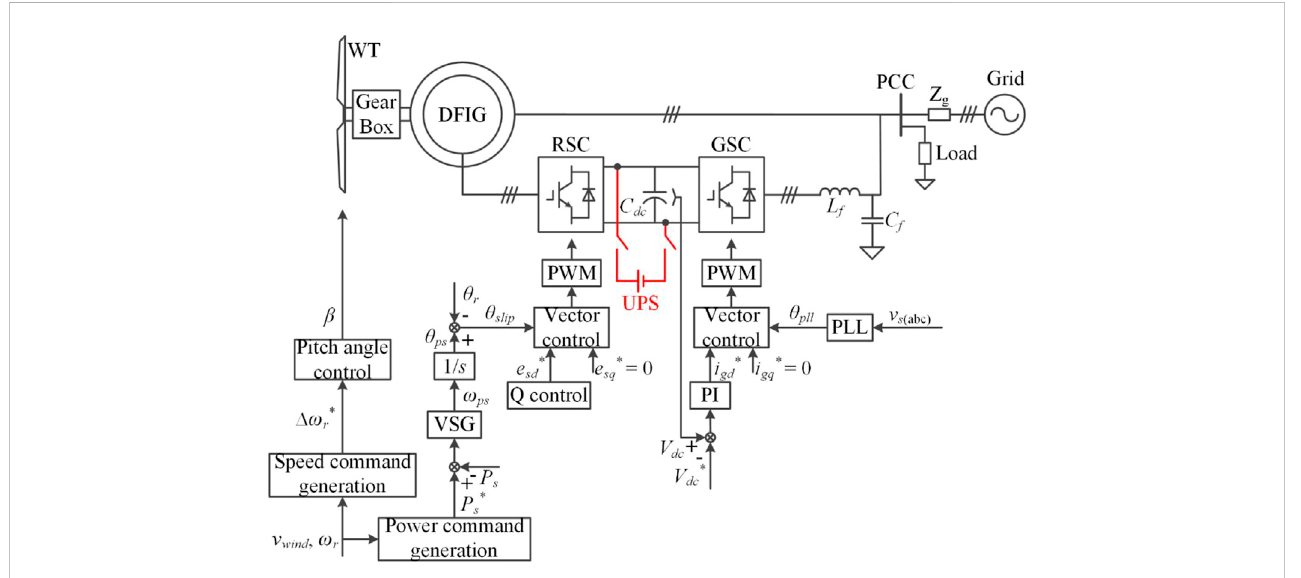
FIGURE 12 GFM control scheme of type-3 wind generator with an auxiliary UPS on the dc-link (Zhu et al., 2018), (Rodríguez-Amenedo et al.,